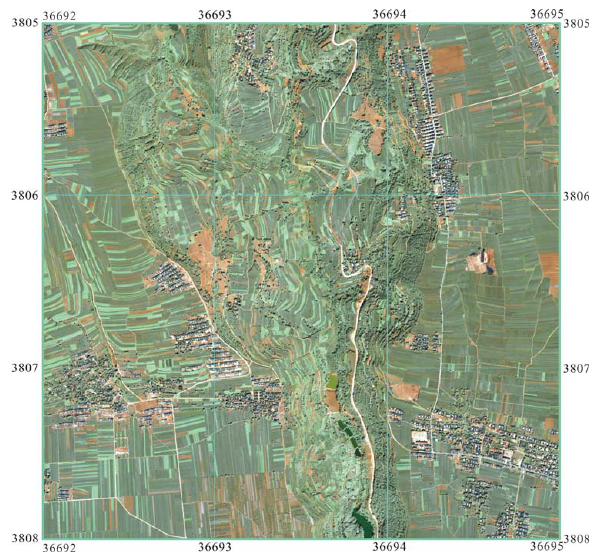
Fig.2 Image showing geomorphological conditions of the Changshougou Valley 114 Fig. 2. Image showing geomorphological conditions of the Chang- shougou The climate of the study area is noted for Asiatic monsoons, marked seasonal shifts in 115 dominant winds being characteristic. The mean annual temperature varies from 7.6 to 116 12.9 °C, and the maximum is up to 41.6 °C. The mean annual precipitation reaches 117 710.24 mm, and the maximum is 1163.3 mm. Almost 50% of the precipitation falls in 118 the period from July to September. The mean annual potential evapotranspiration 119 exceeds 1161.1 mm, and the maximum of daily evapotranspiration is up to 248.8 mm. 120